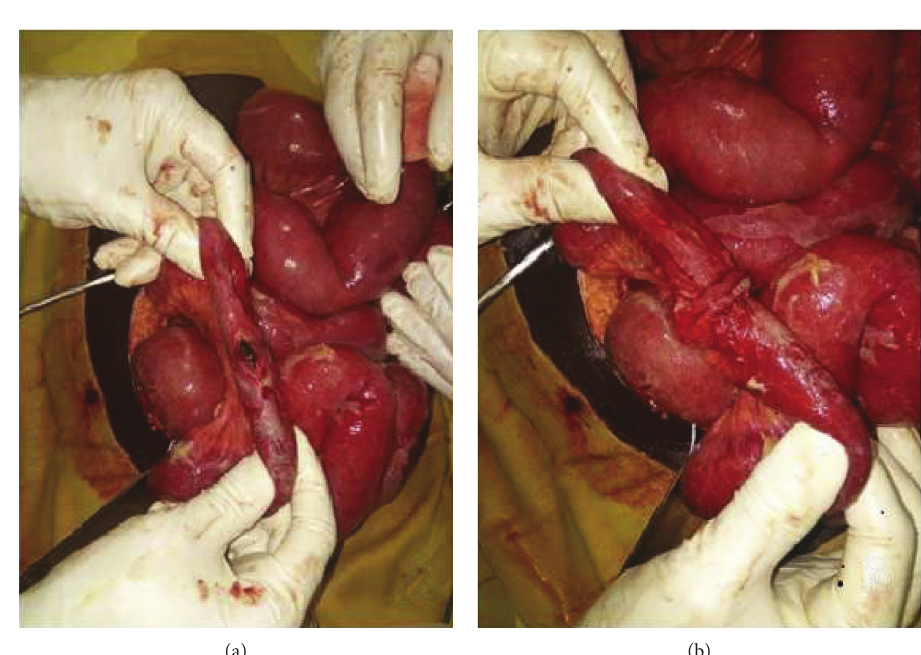
Figure 1: Typhoid ileal perforation (a) and primary repair (b). Primary repair was often adopted and consists of a single-layer suture with 2–4 large Vicryl 2/0 “U” stitches passed through the seromuscular intestinal layer far from perforation where less inflammatory involvement is evident, without edge excision and achieving a good